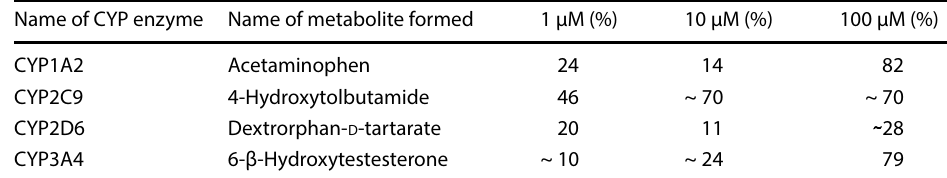
Name of CYP enzyme Name of metabolite